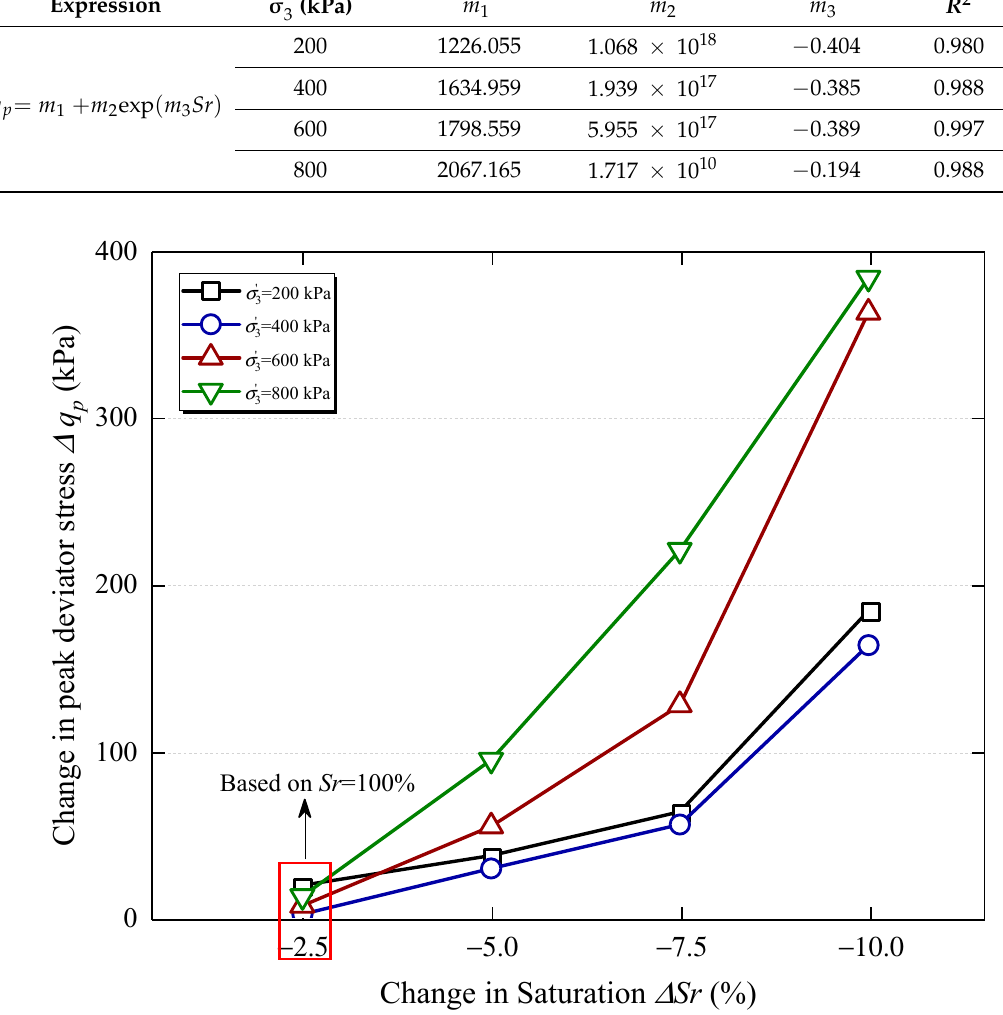
Figure 11. Variations in the peak deviatoric stress with saturation of coral sand.